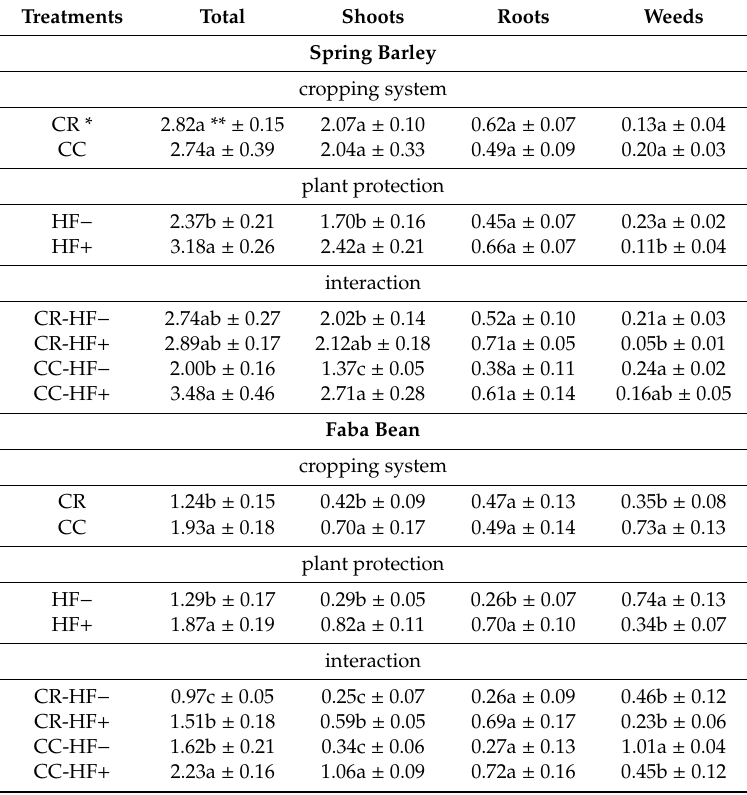
Table 2. Dry mass of post-harvest residues (t ha − 1 ).